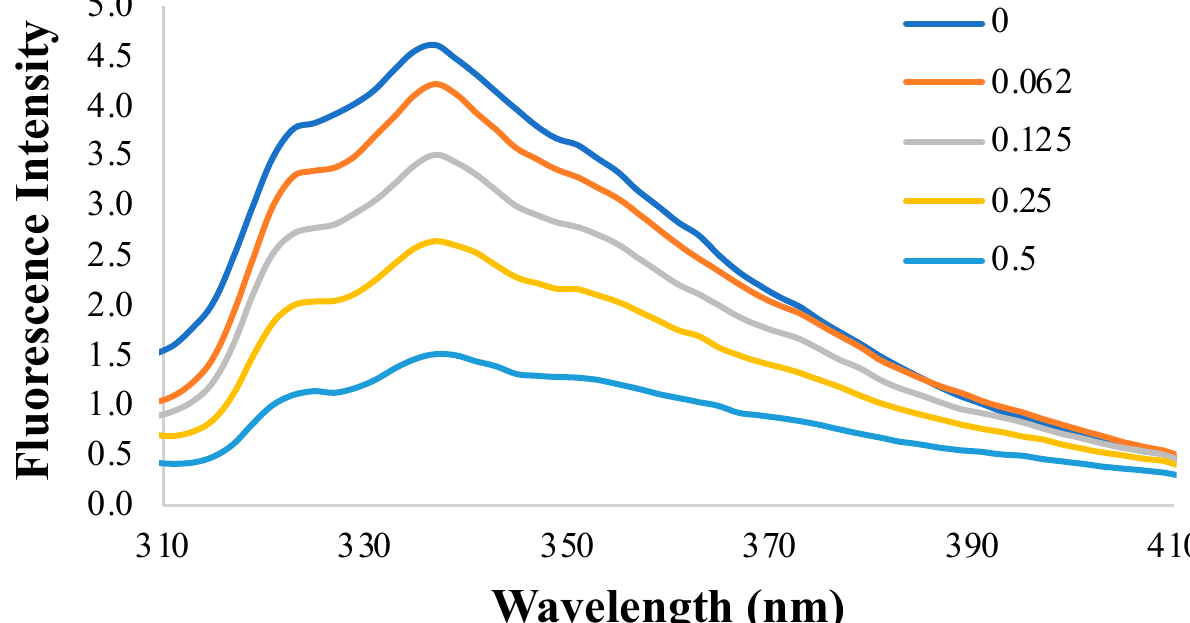
Figure 4. Fluorescence intensity results of dHPI at the excitation wavelength of 295 nm with an increase in HSE concentration (0–0.5 mM) in PBS at pH 7 and room temperature .